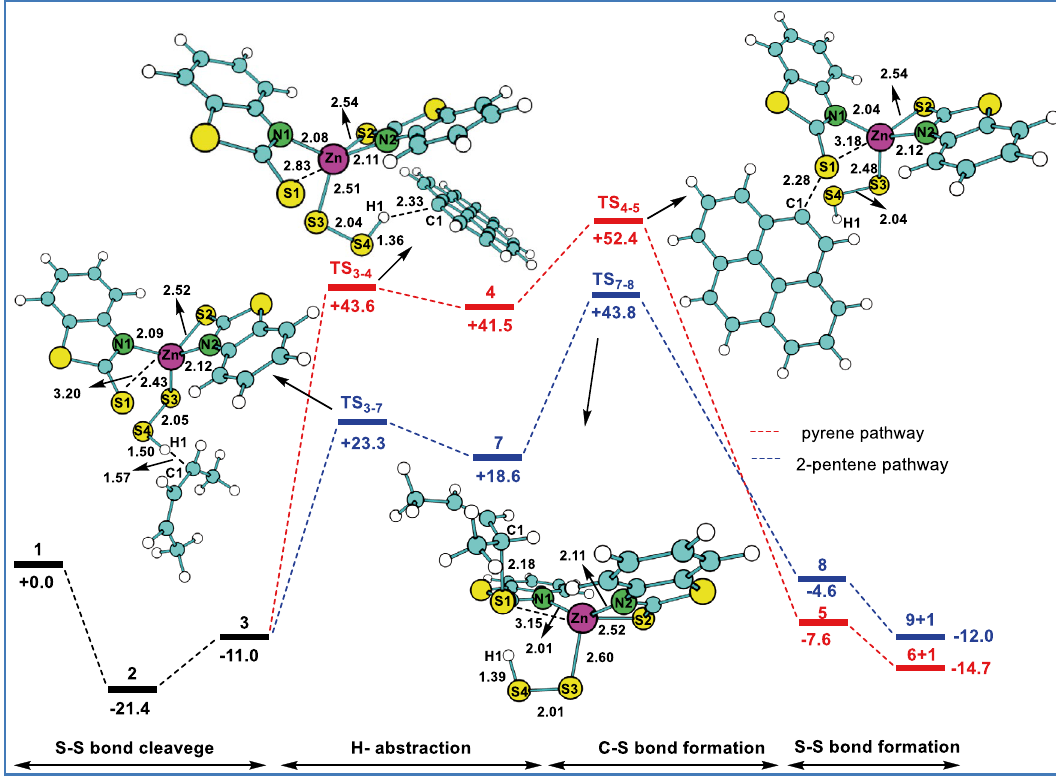
Figure 8. Computed free energy profile for the ZMBT mediated sulfuration of pyrene and 2-pentene. Optimized transition states are shown with bond distances